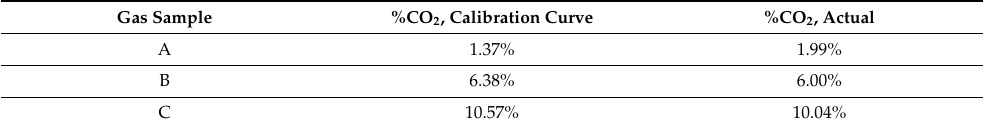
Table 1. Blind study was done for three unknown CO 2 concentrations to understand the trustworthi- ness of the derived equation. See Figure S7.